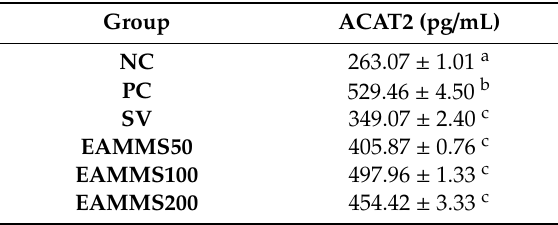
Table 7. E ff ect of ethyl acetate extract of Mikania micrantha stems (EAMMS) on ACAT2 levels in all treated experimental rats at week